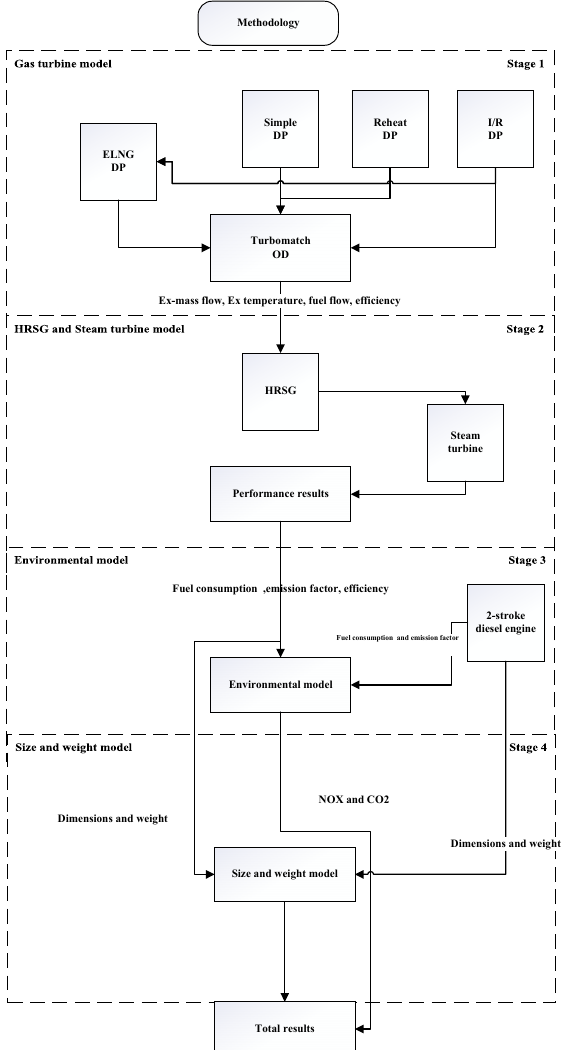
Figure 1. Flowchart of the methodology employed in this study. NOx: Nitrogen oxide; CO 2 : carbon dioxide; CCGT: combined-cycle gas turbine (with steam); I/R: intercooler–reheat cycle; HRSG: heat recovery steam generator; ELNG: enhanced liquefied natural gas.